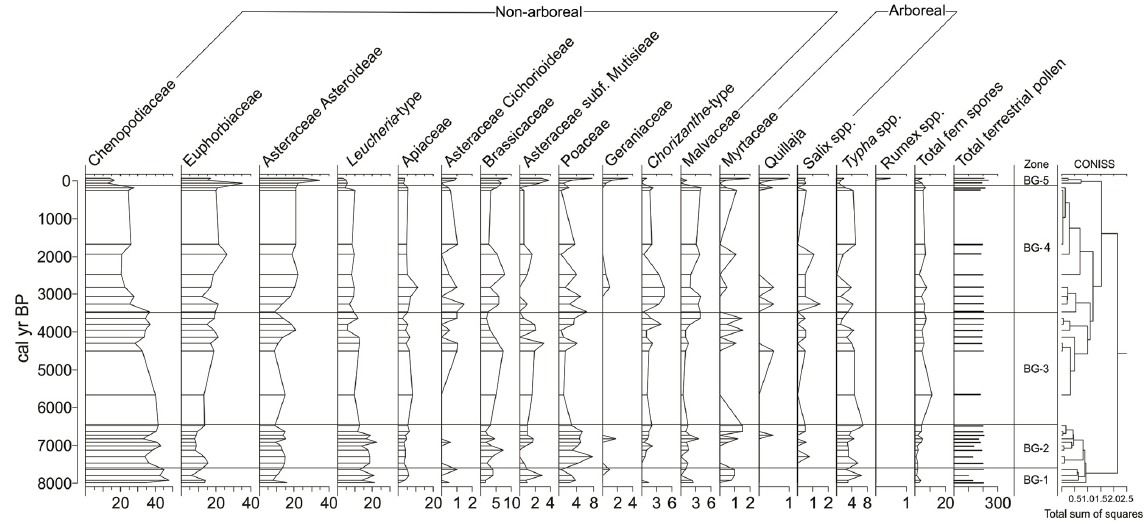
Figure 7. Pollen record in core